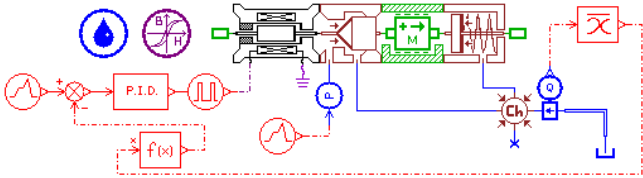
Figure 11. Single valve closed-loop control model.